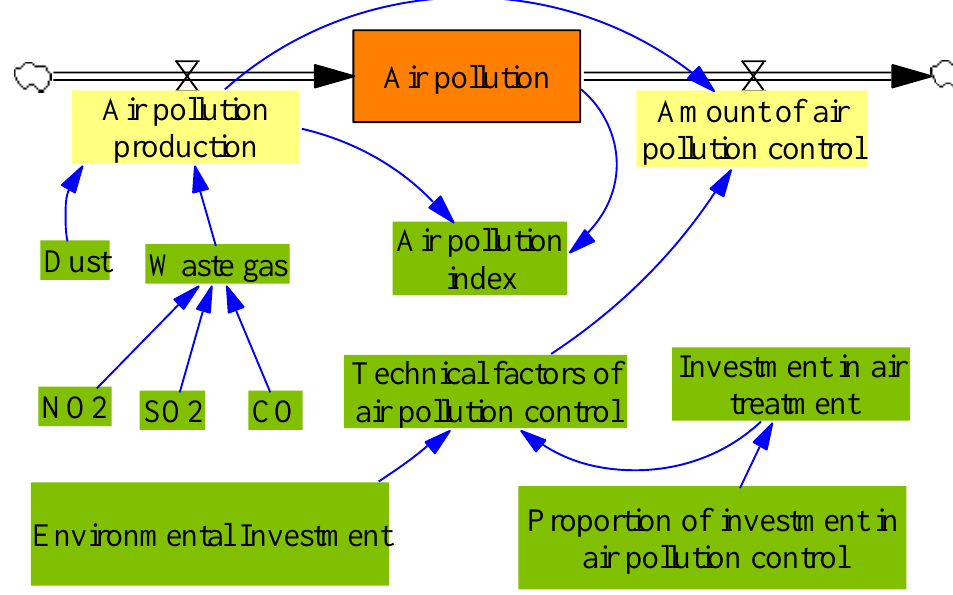
Figure 2. The system flow diagram of atmospheric subsystem.